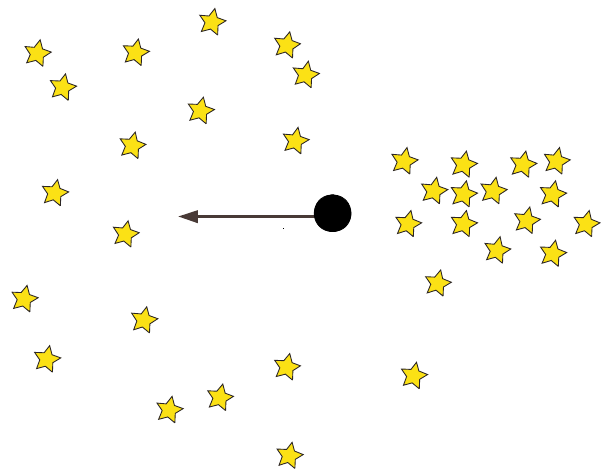
Fig. 17 The accumulation of stars right behind the massive perturber creates a region of stellar overdensity that acts on the perturber, slowing it down, braking it